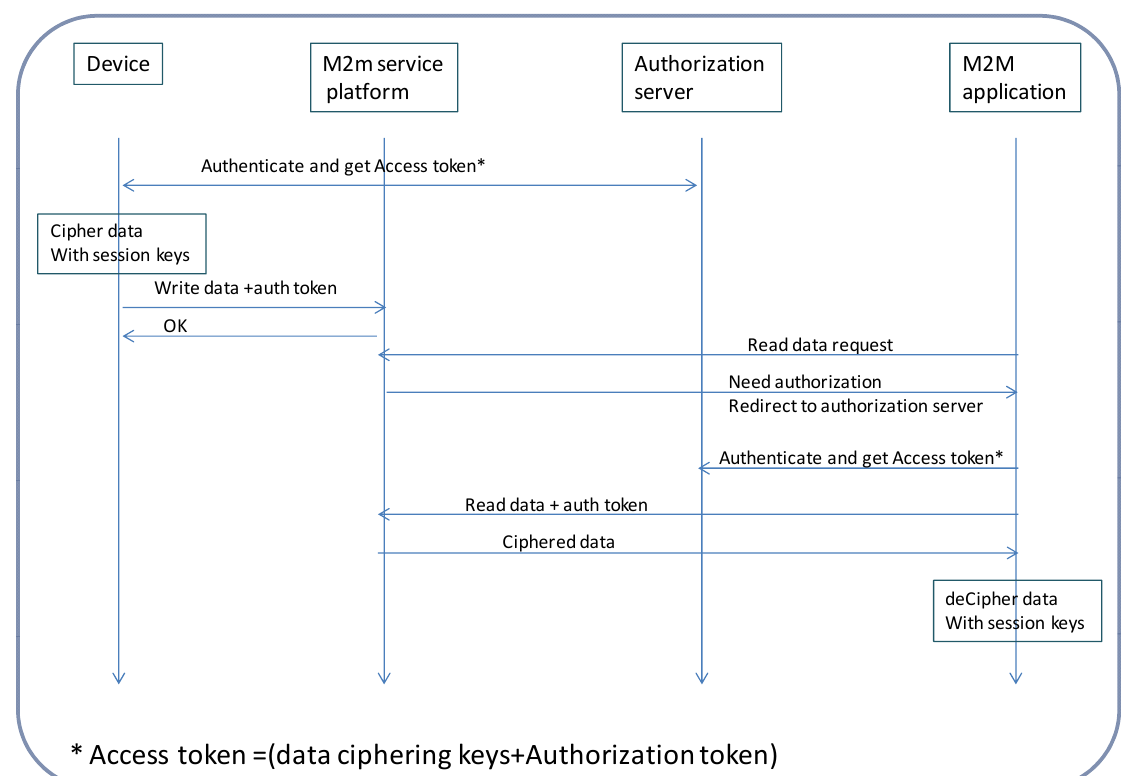
Figure 17. Flow of operations when transferring data from device to